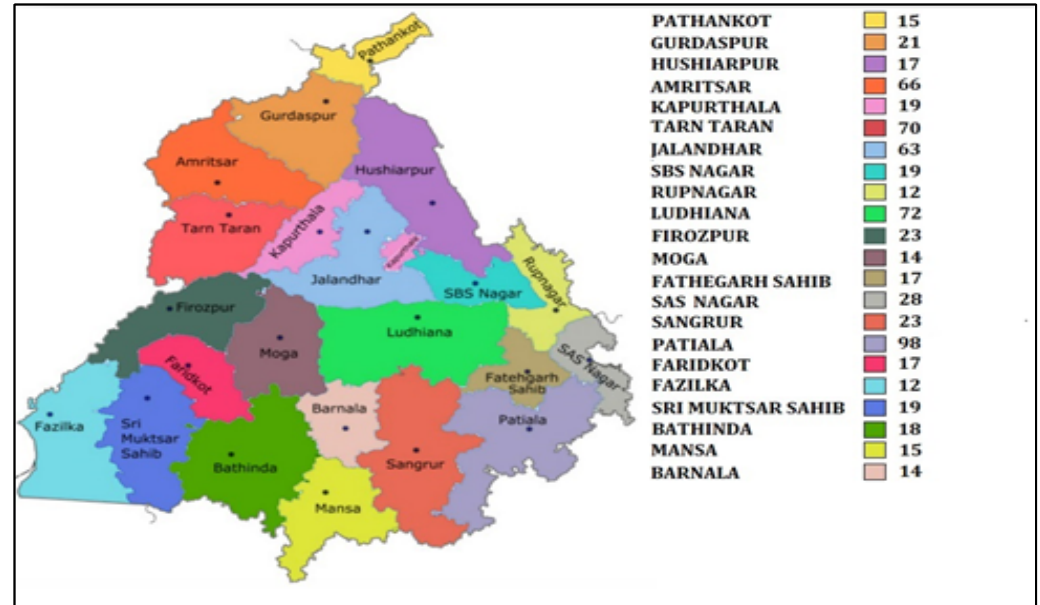
Figure 1. Map of Punjab showing district wise sample collection.